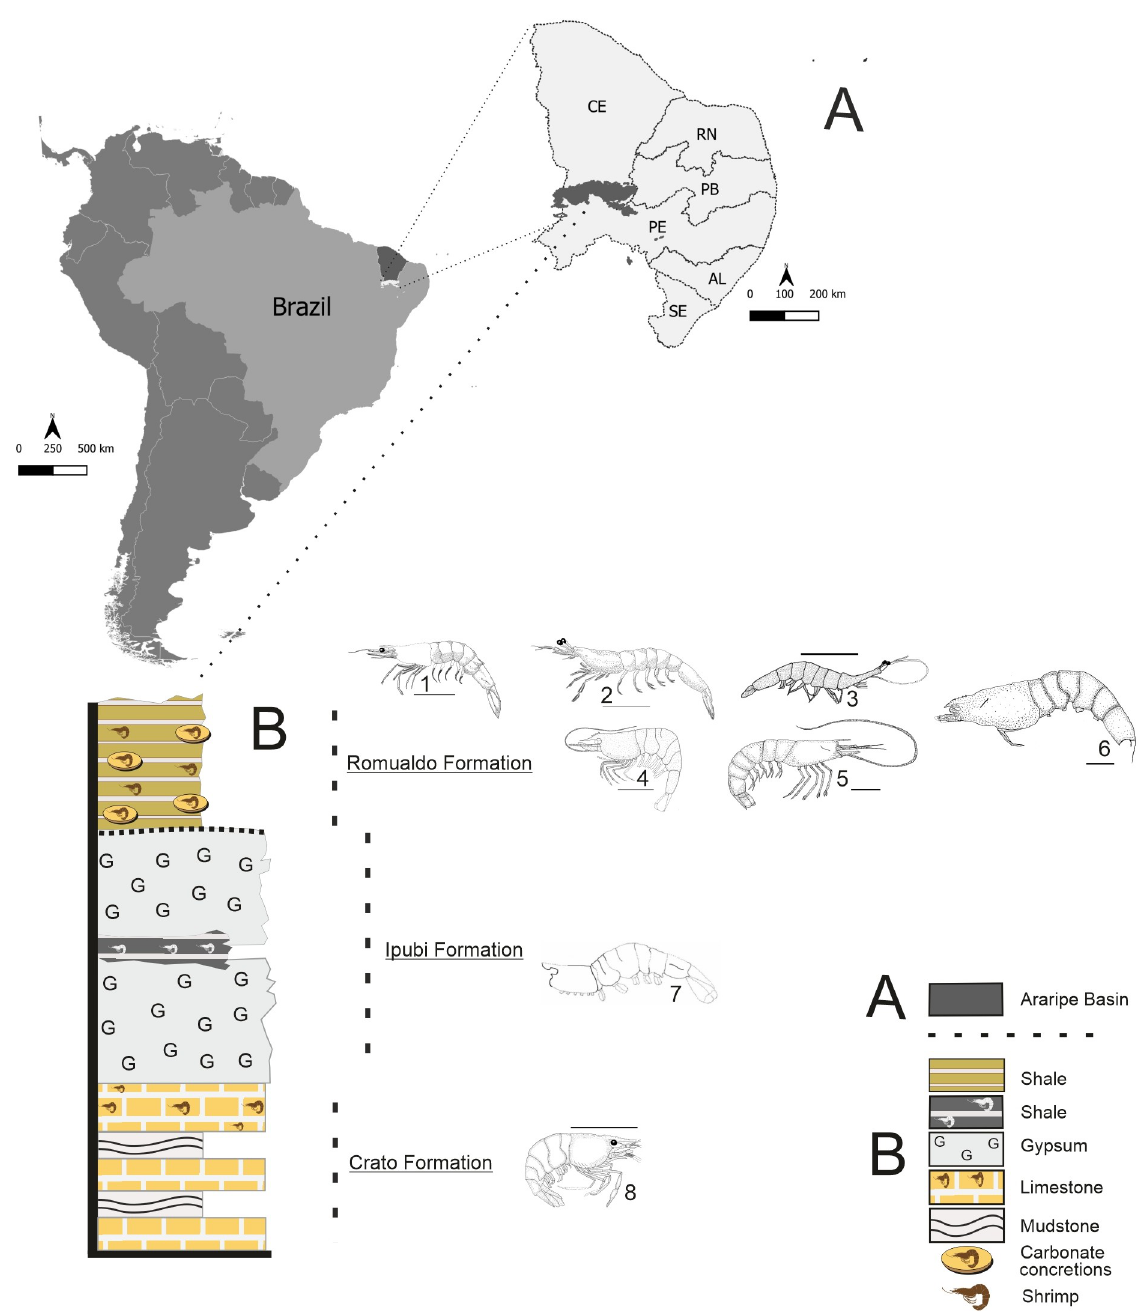
Fig 1. South America map with Brazil highlighted. (A) Northeastern Brazil with location of the Araripe Basin (south of the Ceara´ State). (B) Shrimps that are found in Santana Group: 1. Araripenaeus timidus , 2. Paleomattea deliciosa , 3. Sume marcosi , 4. Kellnerius jamacaruensis , 5. Cretainermis pernambucensis , 6. Priorhyncha feitosai , 7. indeterminate Caridea, 8. Beurlenia araripensis , drawn by Olga A. Barros with base in the descriptions: [3,7,9–13]. https://doi.org/10.1371/journal.pone.0247497.g001 Rio de Janeiro (UFRJ, Brazil). All the studied samples were taken from the above institutions with the necessary permits, complying with every applicable regulation. All the images ana- lyzed in this work were obtained by the authors with proper permissions from the institutions listed above.